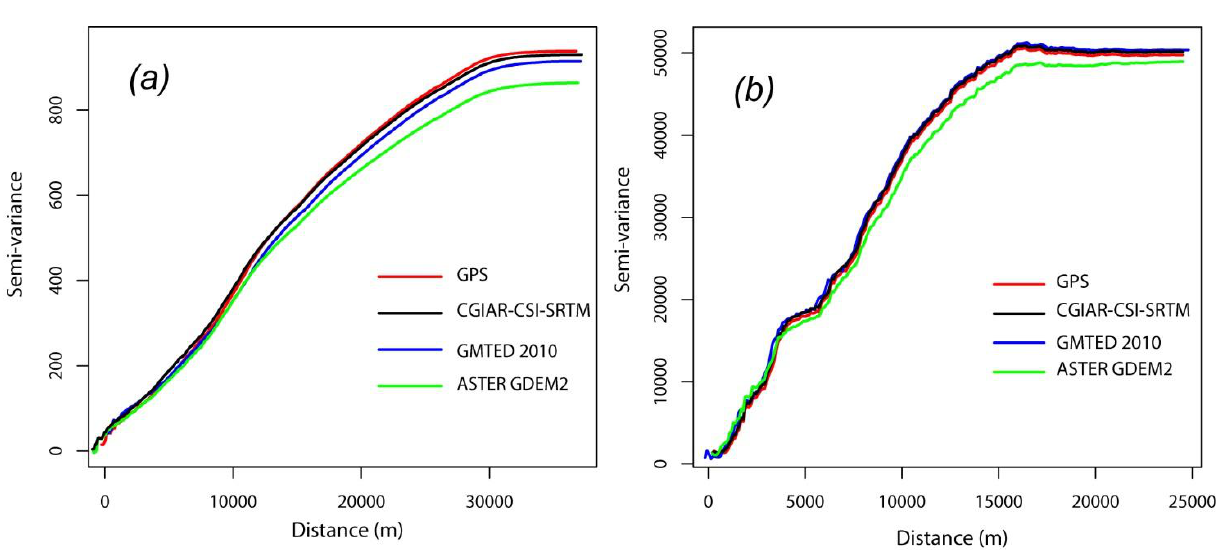
Figure 6. Empirical variograms of the three DEMs compared with that of GNSS elevations points for each test site: ( a ) Anaguid and ( b ) Tebessa. The red, black, blue and green variograms represent GNSS, SRTM v4.1, GMTED2010 and ASTER GDEM2,